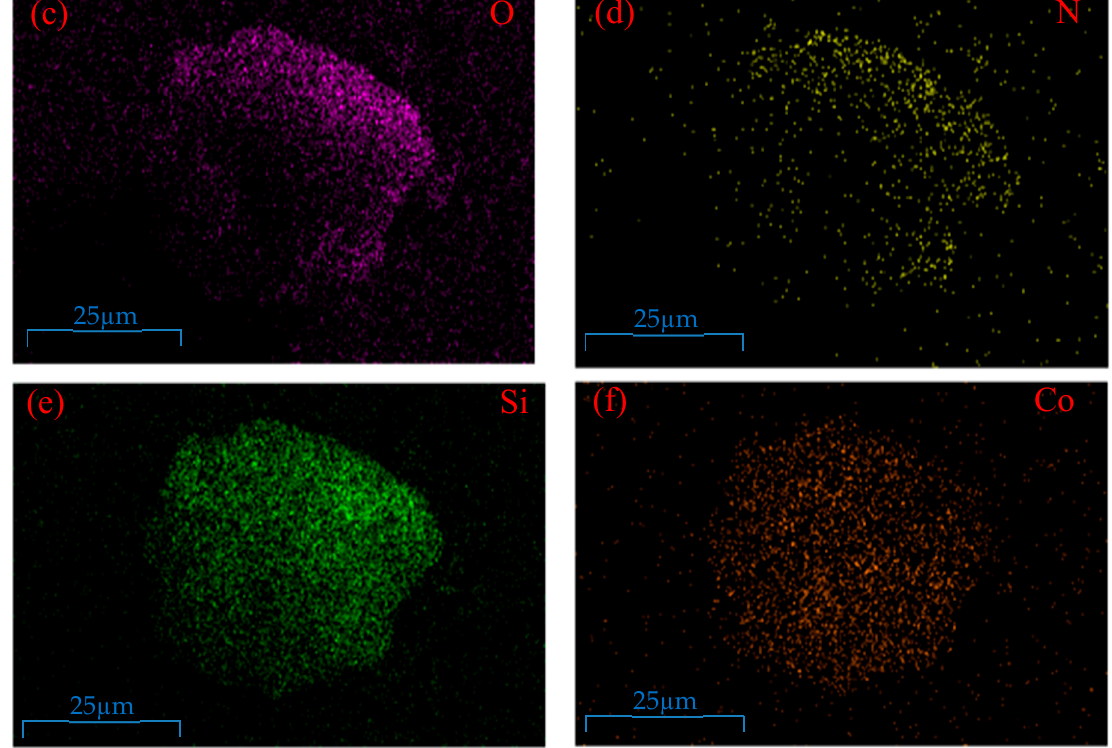
Figure 5. ( a ) SEM with X-ray area scanning; EDS mappings of ( b ) Fe, ( c ) O, ( d ) N, ( e ) Si, and ( f ) Co of CoFe 2 O 4 @SiO 2 -Ppy.